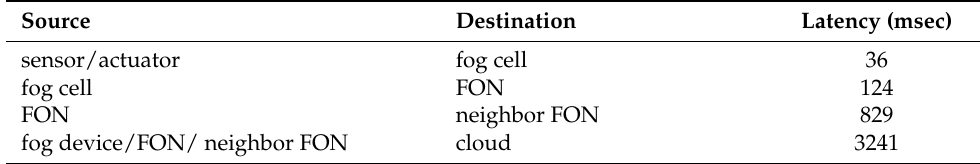
Table 5. Description of network links for Smart